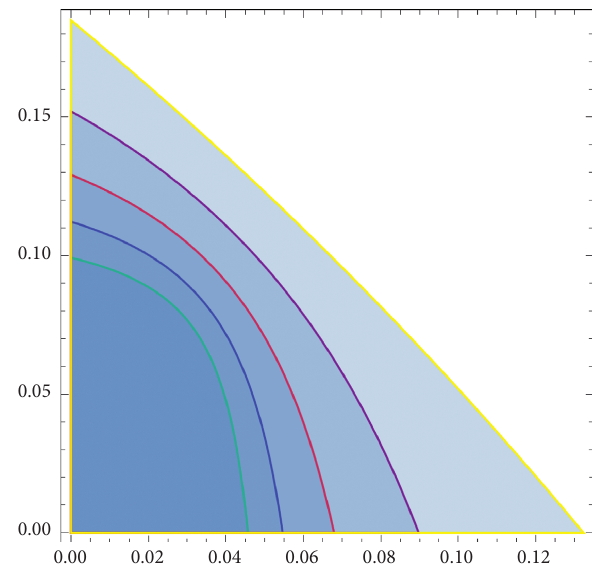
Figure 15: The stable region with change of β